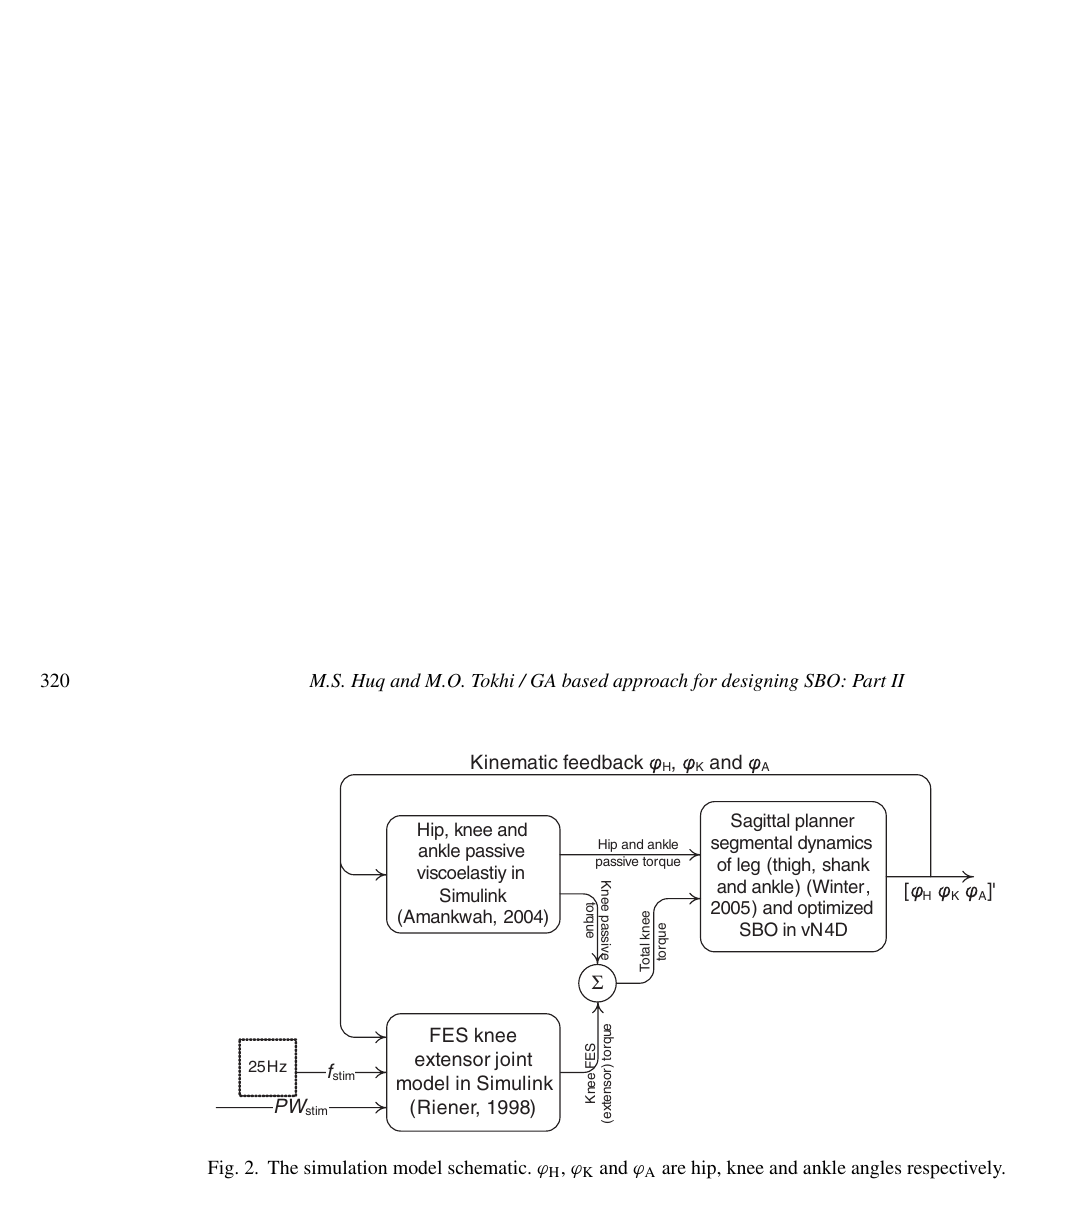
(corresponding to knee joint angle of 72.004 ◦ ) respectively.